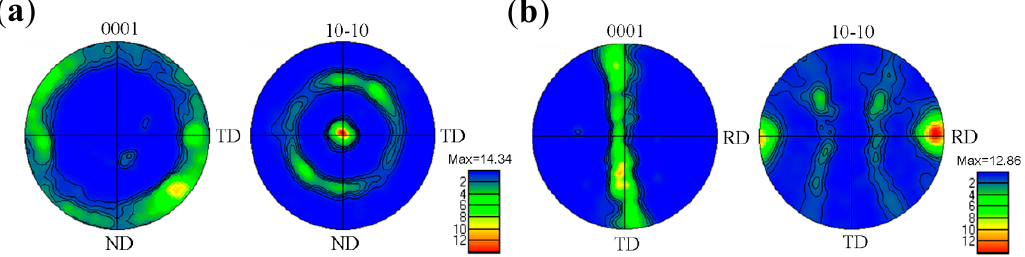
Figure 4. The pole figures for RSA450 sample: basal plane {0001} and prismatic plane {10-10} for transversal section ( a ) and longitudinal section ( b ), the rolling direction alone rod axis, the normal direction and the transverse direction were labeled as RD, ND, and TD, respectively.